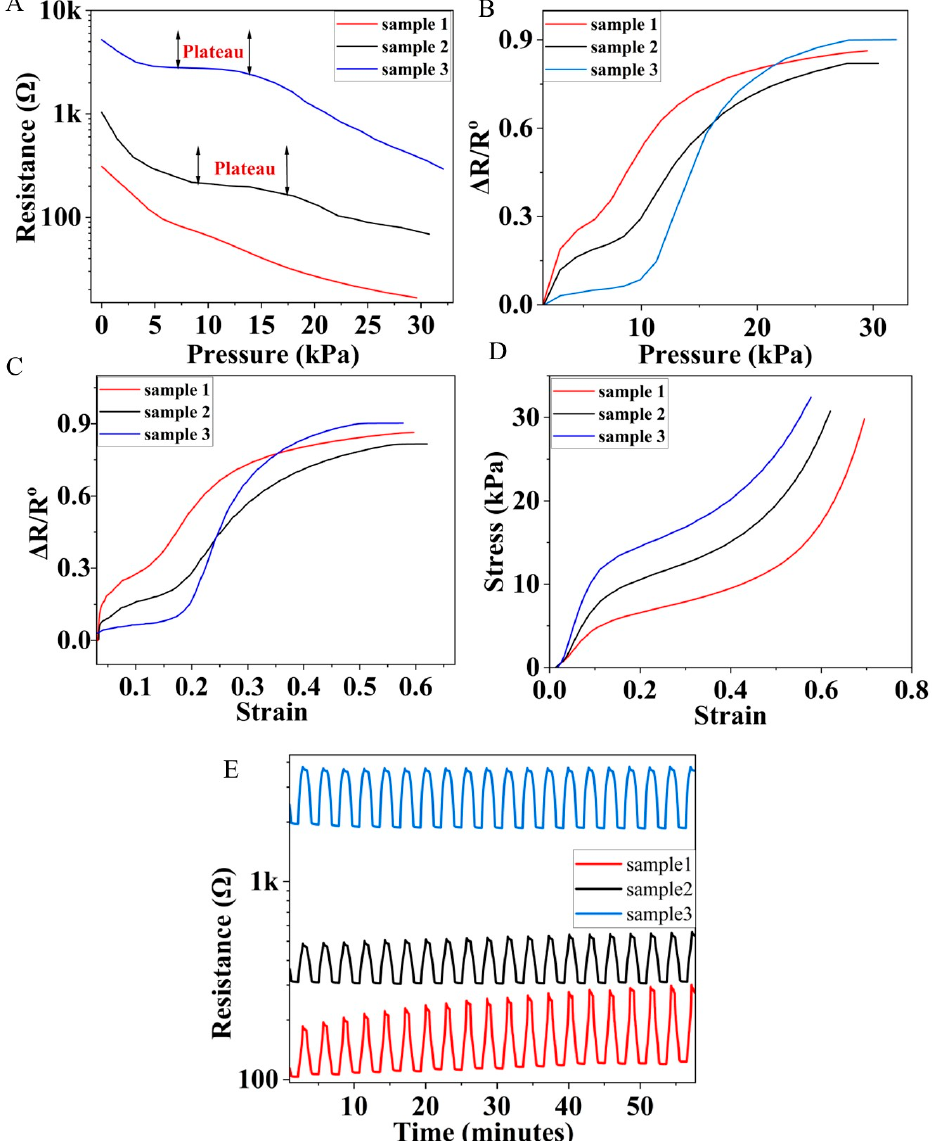
Figure 4. Resistance vs. pressure plots ( A ), pressure sensitivity ( B ), gauge factor ( C ), stress–strain curves ( D ), and cyclic lo€ ( E ) of the developed N-BCNT/PU sensors (sample 1, sample 2, and sample strain curves ( D ), and cyclic load ( E ) of the developed N-BCNT/PU sensors (sample 1, sample 3). 2, and sample